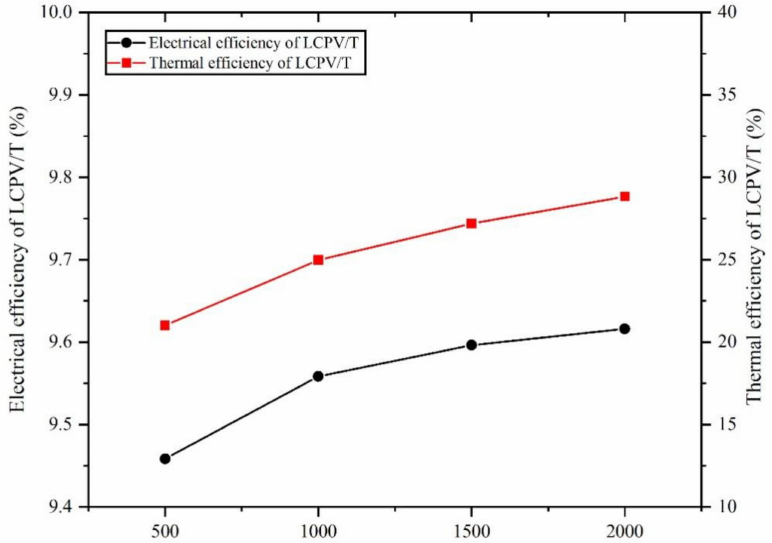
Figure 20. Electrical efficiency and thermal efficiency of LCPV/T under variable air flow rate.